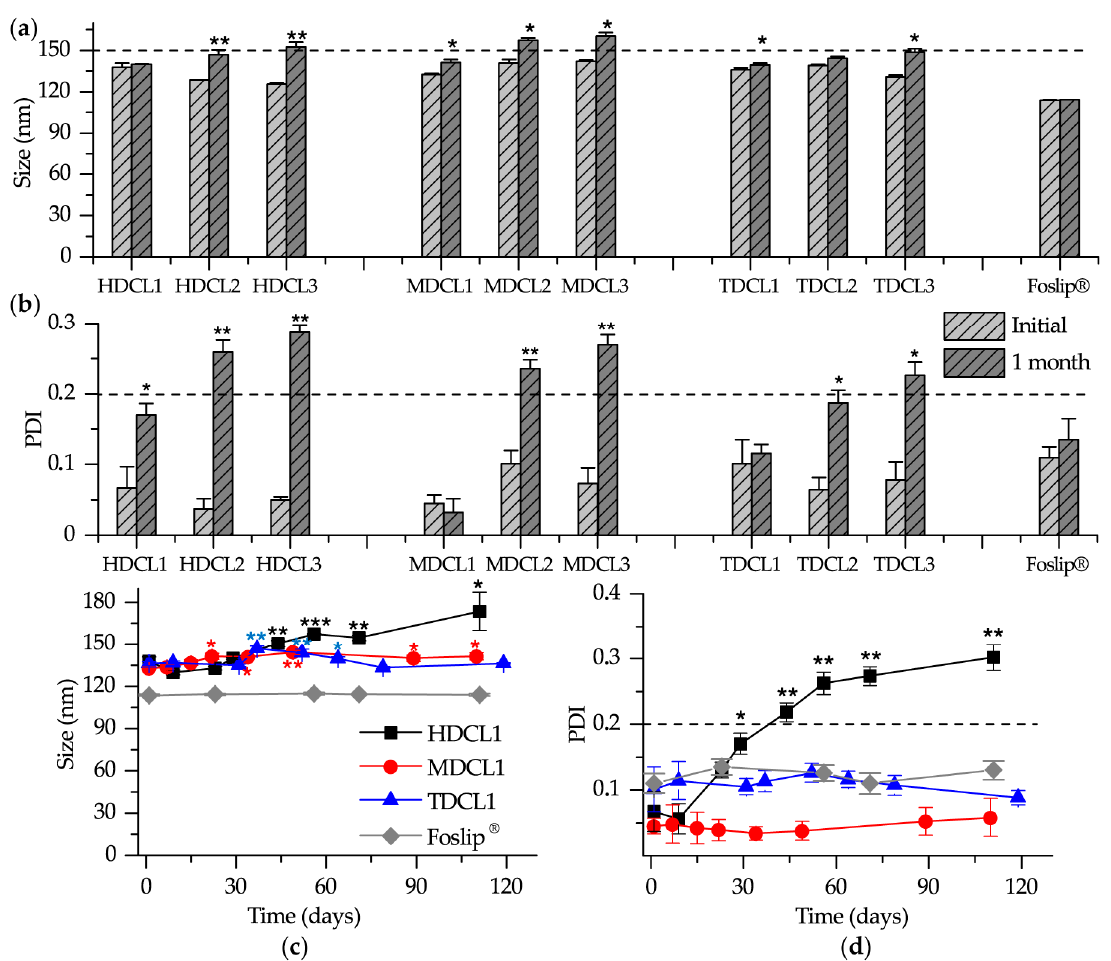
Figure 3. ( a ) Size and ( b ) polydispersity index (PDI) of mTHPC formulations after one month of the storage. Kinetics of ( c ) size and ( d ) PDI of HDCL1, MDCL1, TDCL1 and Foslip ® during three months of storage. The samples were stored at 4 °C in the dark. The samples were diluted 1000 times in ultrapure water (UPW). *—statistically different from initial sample, P < 0.05; **—statistically different from initial sample, P < 0.01, ***—statistically different from initial sample, P < 0.001.